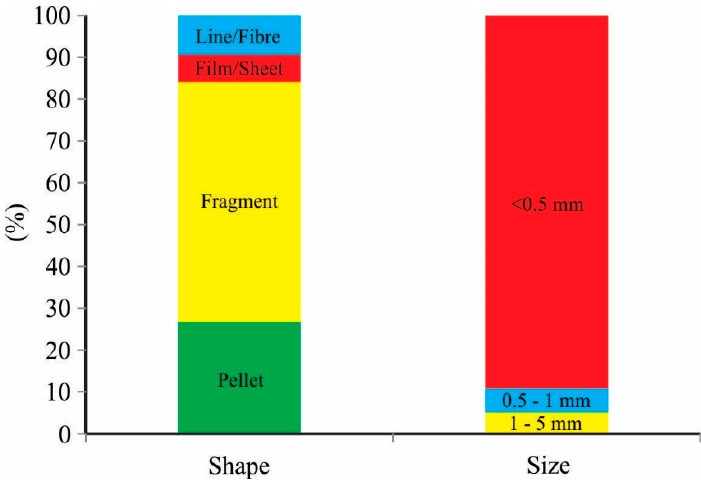
Figure 3. Shape and size of the identified MPs from the SDR sediments.